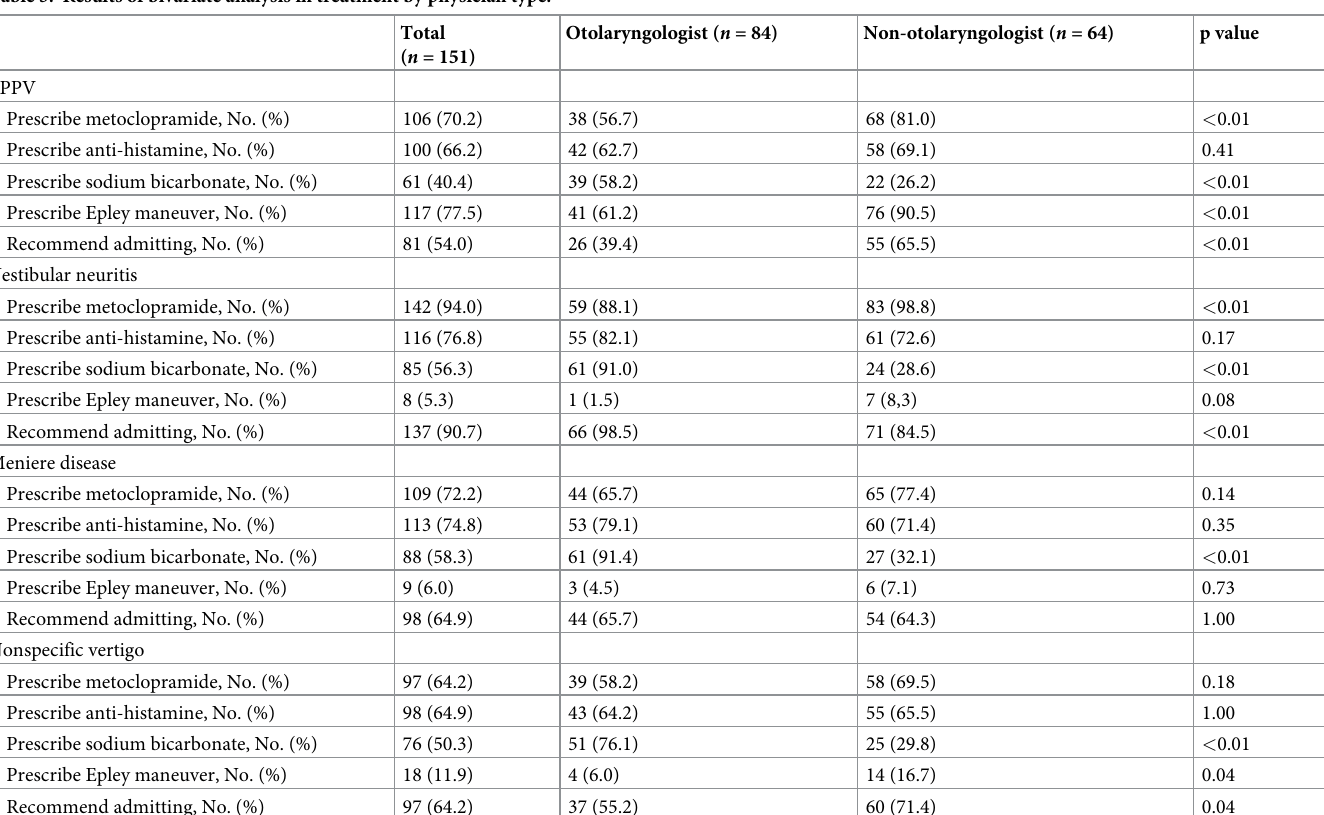
Table 3. Results of bivariate analysis in treatment by physician